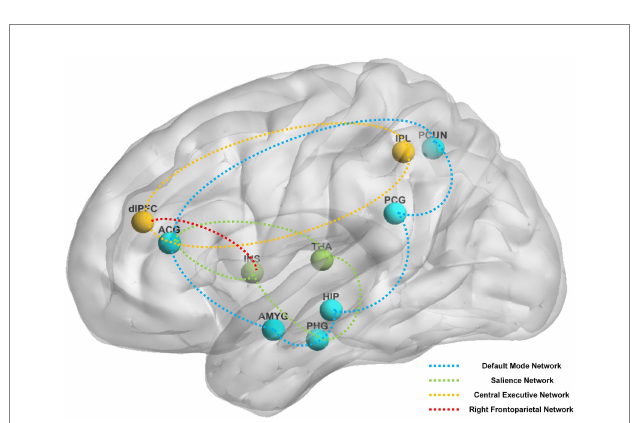
FIGURE 4 The main reported alternation of brain regions and networks by instant acupuncture across the studies reviewed. Brain regions: ACG, anterior cingulate and paracingulate gyri; AMYG, amygdala; dlPFC, dorsolateral prefrontal cortex; HIP, hippocampus; INS, insula; IPL, Inferior parietal, but supramarginal and angular gyri; PCG, posterior cingulate gyrus; PCUN, precuneus; PHG, parahippocampal gyrus; THA, thalamus. Brain networks: blue network, default mode network; green network, salience network; yellow network, central executive network; red network, right frontoparietal network.